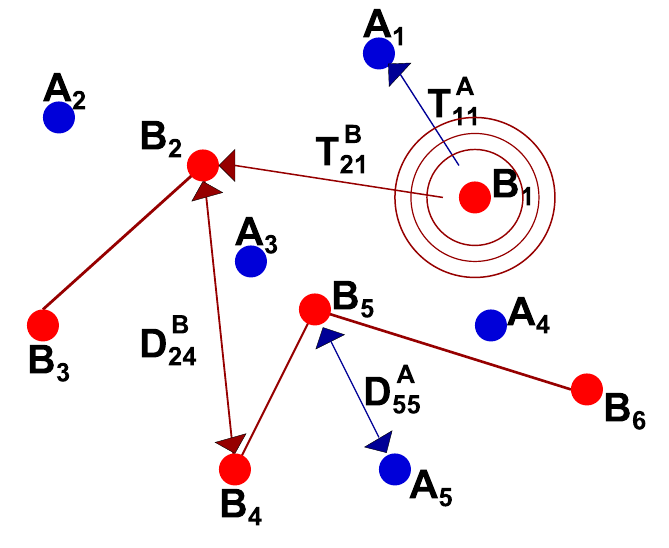
Figure 2. Reference scenario with 5 anchors and 6 blind